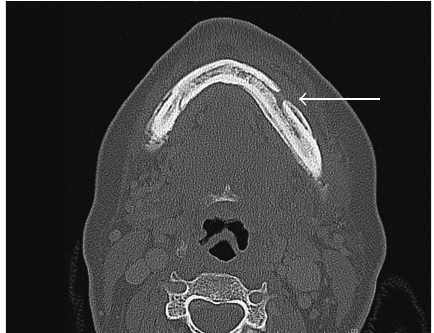
Figure 3: Repeat CT scan of the mandible. Repeat CT scan of the mandible showed changes along the external and internal surface of the mandible (arrow) with production of new bone along the body extending to the mandibular angle thought to be secondary to osteonecrosis from the radiation therapy.